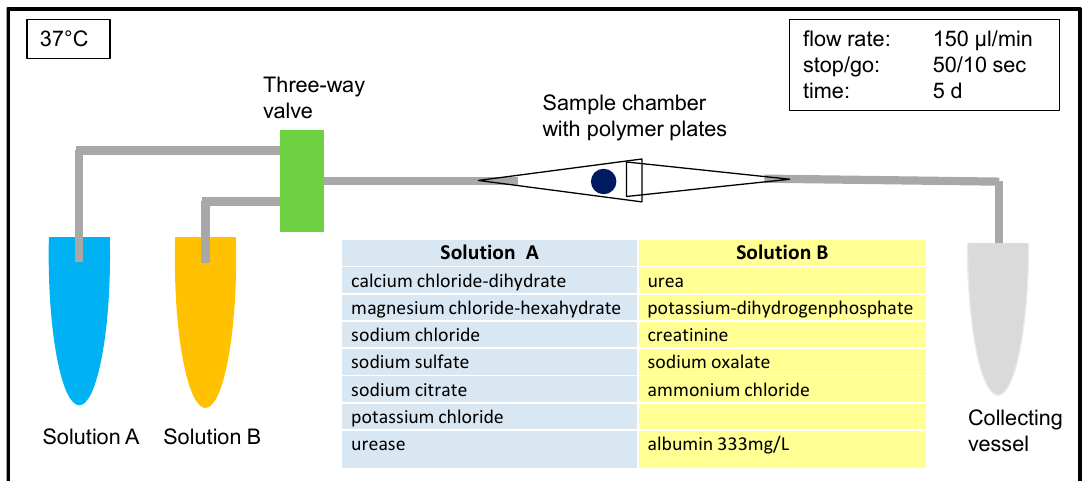
Figure 1. Scheme of the in vitro encrustation system. All components are placed in a heating chamber to maintain 37 °C. Solutions A+B are mixed in the three-way valve, subsequently leading to encrustations crystallizing on the polymer pieces placed in the sample compartment. Formulation of the synthetic urine adopted from [8].